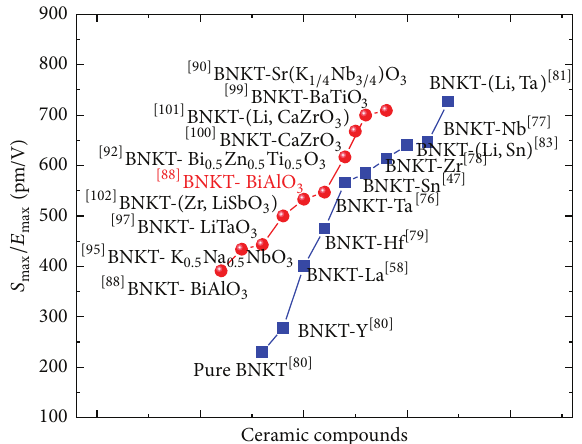
Figure 2: The effect of dopants and solid solution perovskite AB O 3 to